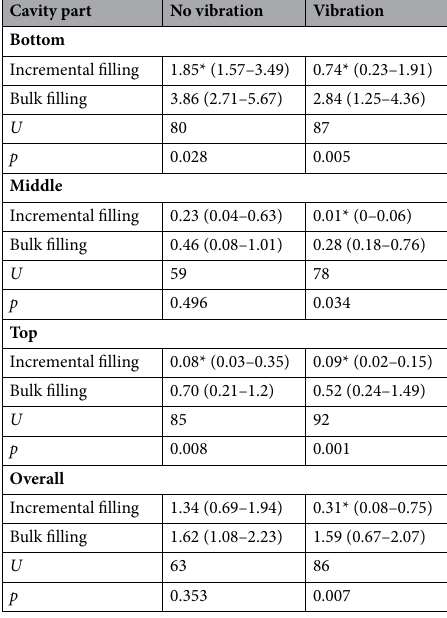
Table 5. Void volume (%) in the bottom, middle, top, and overall cavity for incremental and bulk fillings. Interquartile ranges (first quartile, third quartile) are in parentheses. An asterisk indicates significantly lower void volume within same part between incremental fillings and bulk fillings (column) (Mann–Whitney U test, p < 0.05). U, U-value; p,